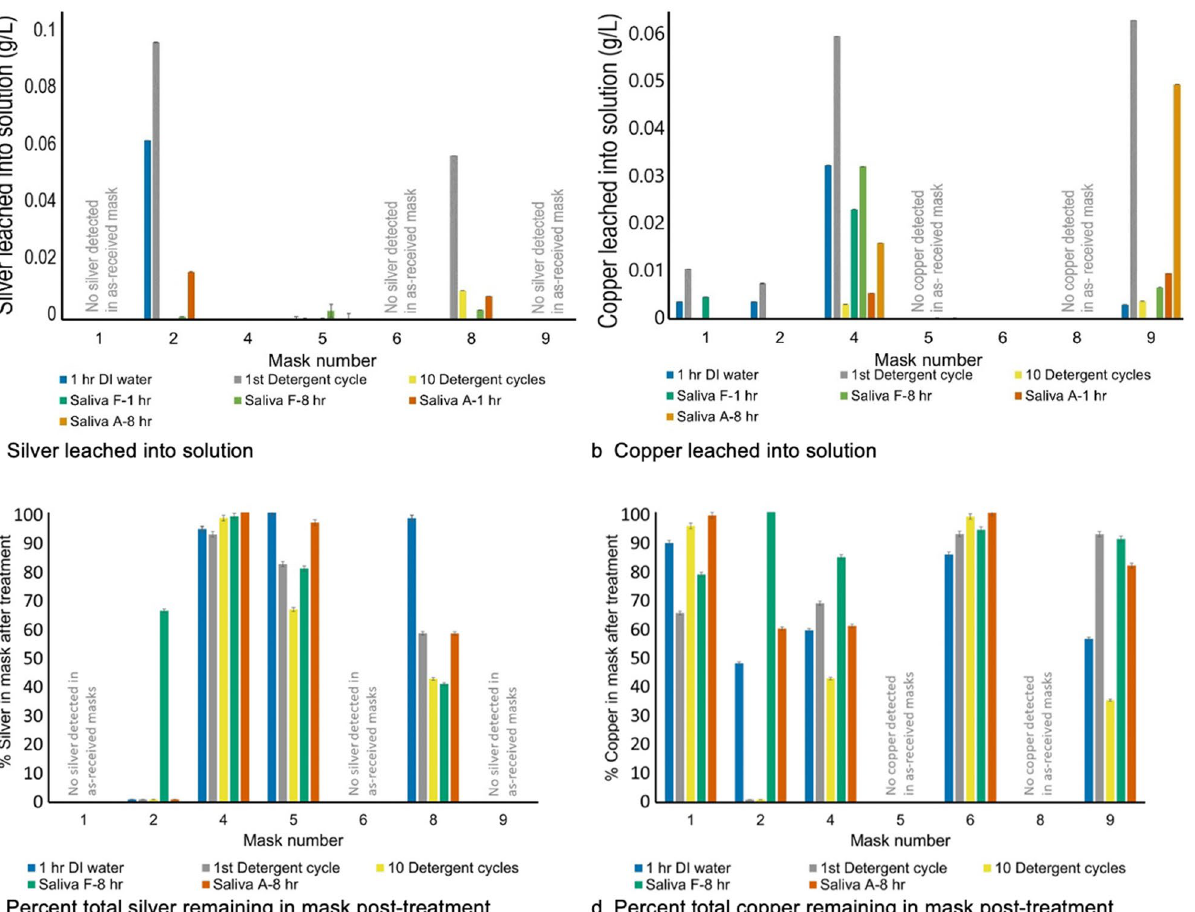
Figure 1. Total silver and/or copper leached into treatment solution ( a , b ) and present in masks post-treatment ( c , d ); error bars represent ± one standard deviation about the